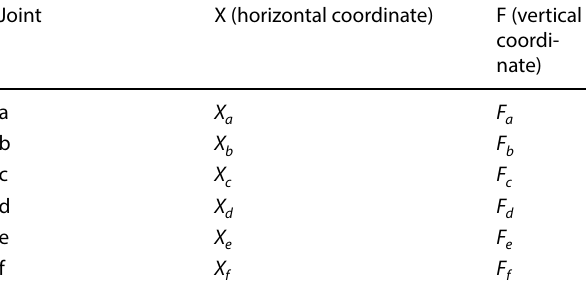
Table 1 Symbols assigned to coordinates of inflection points